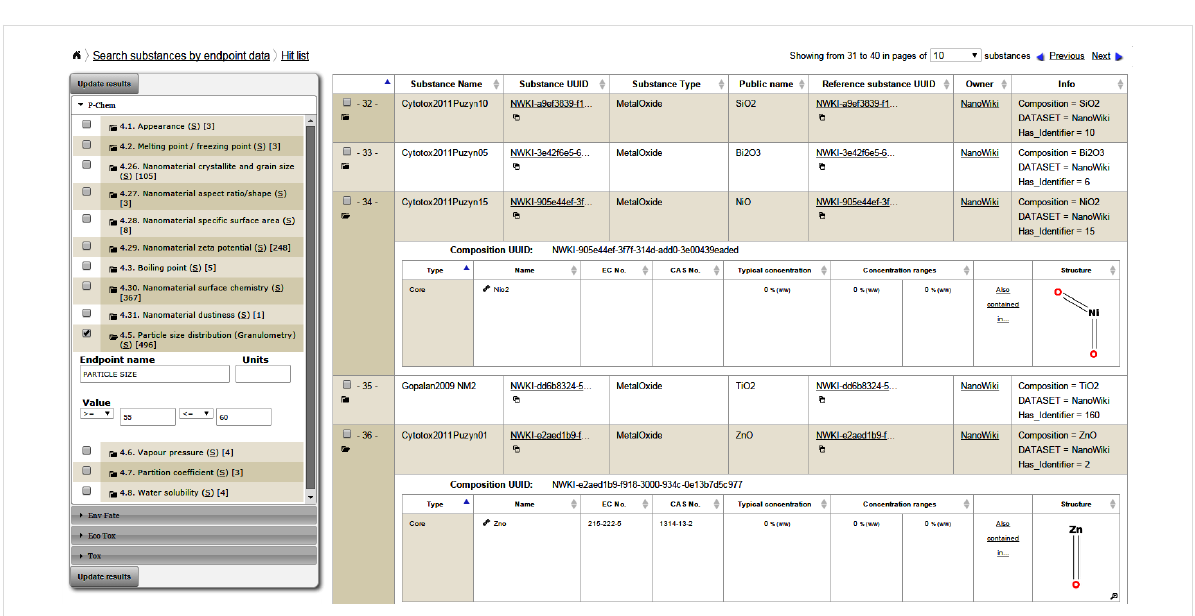
Figure 14: Screenshot showing query results in the NanoWiki data set for particle sizes between 50 and 60 nm. The widget at the left side repre- sents an overview of all experimental data in the system, organized in four groups of physicochemical, environmental, ecotoxicological and toxicity sections. Each section lists available endpoints and the number of available data entries. The text boxes support auto-completion, i.e., the available values will be displayed and can be selected by either pressing an arrow-down button (to list all available values) or by entering the first letters of a possible